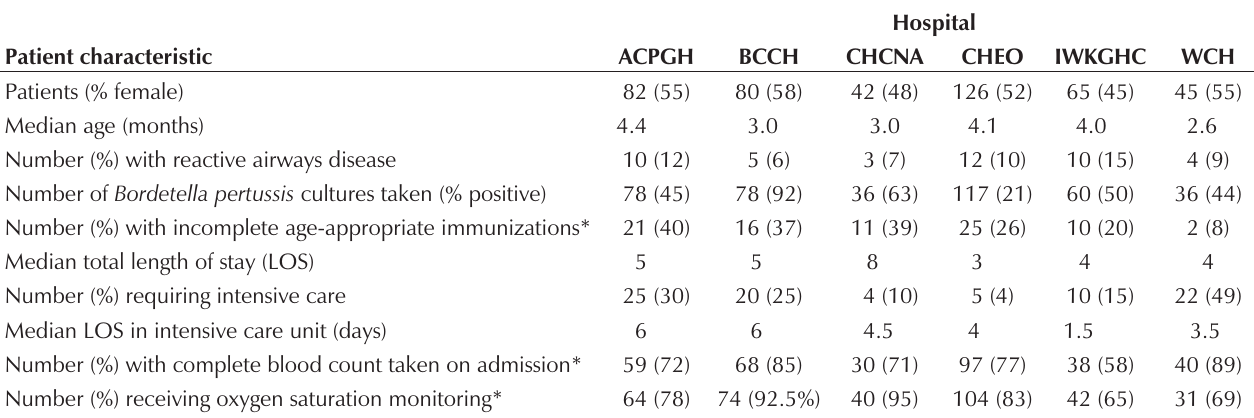
Demographics of 440 children admitted to six tertiary care hospitals with a primary admission diagnosis of pertussis